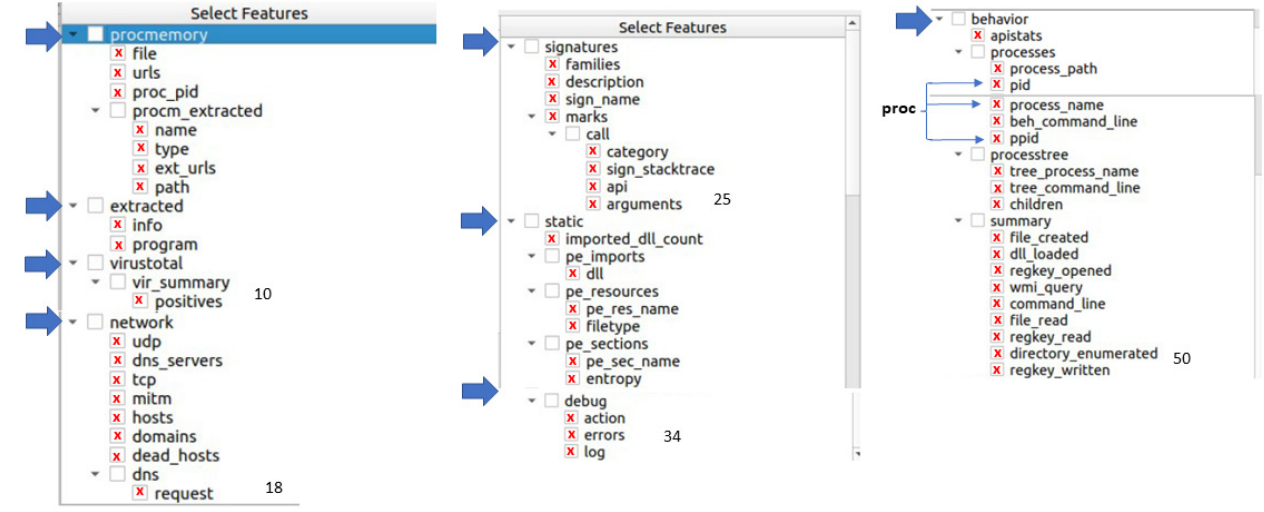
Figure 4. Feature extraction tool GUI for final 50 characteristics. Table 3. Selected features inside JSON objects.